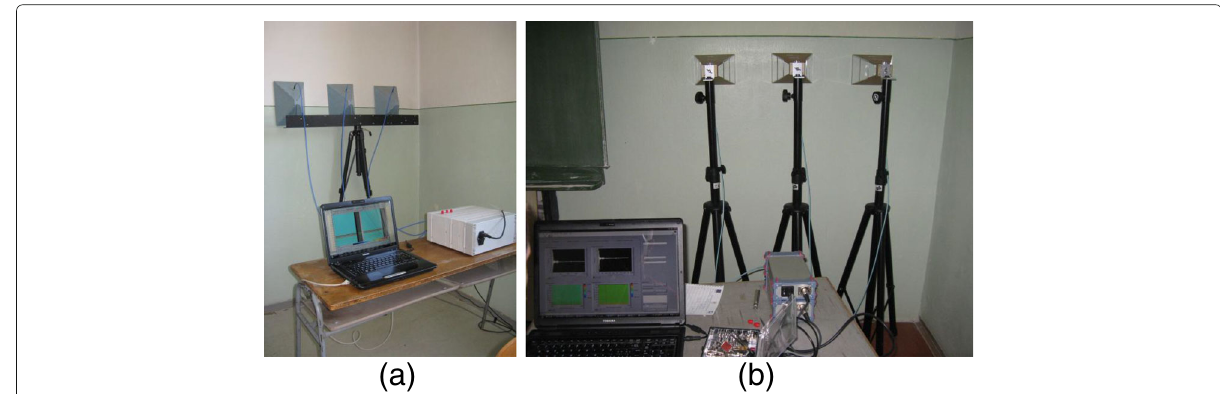
Fig. 4 The measurement devices and their locations. a Sensor S1. b Sensor